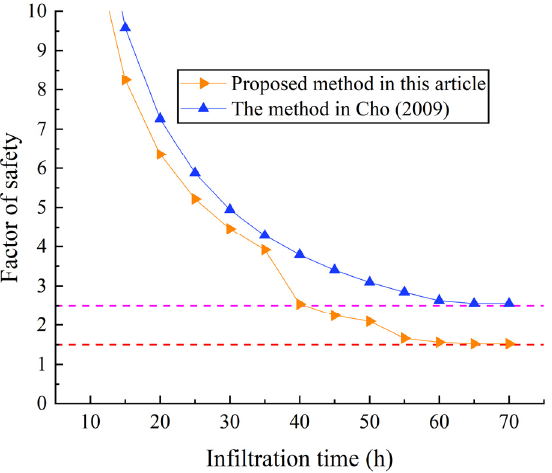
Figure 14. Factor of safety of the capillary barrier cover with the variation of infiltration time.